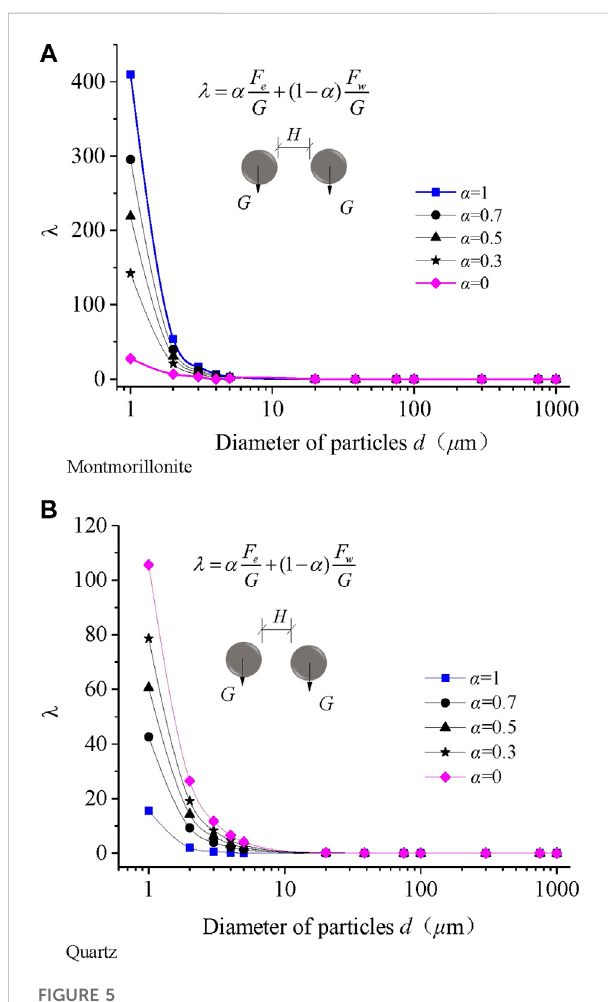
called the particle ’ s surface energy. This adsorption energy is mainly manifested as the van der Waals force between particles and the electric fi eld force generated by the excess charges on the particle surface. At the micro-level, the forces with high size factor power, such as gravity and inertial force, are relatively small; while the forces with low size factor power, such as surface tension, van der Waals force, and electric fi eld force, are relatively large, as shown in Figure 4. The surface and contact interface features of the particles are produced mainly by the direct action of these forces. Among these forces, gravity, van der Waals force, and Coulomb force can be used to characterize both the particle size and the mineral composition of soil particles.